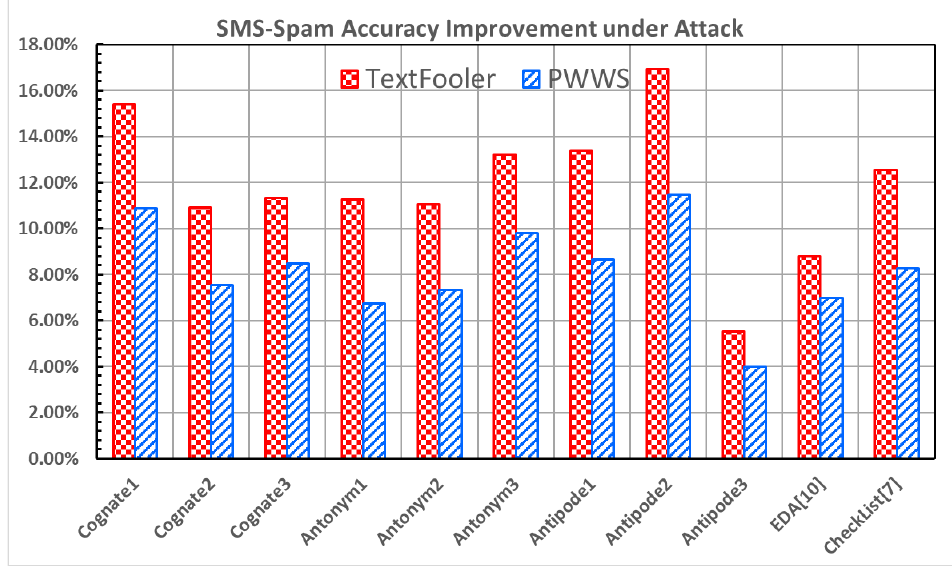
Figure 11. SMS-Spam Accuracy Improvement Under Attack.